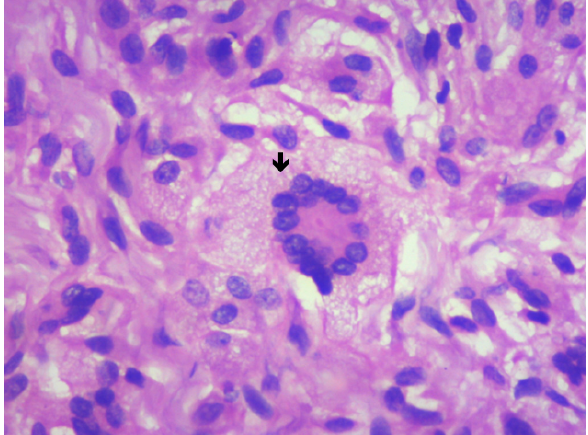
Figure 7: Magnified image (40x) showing the Touton